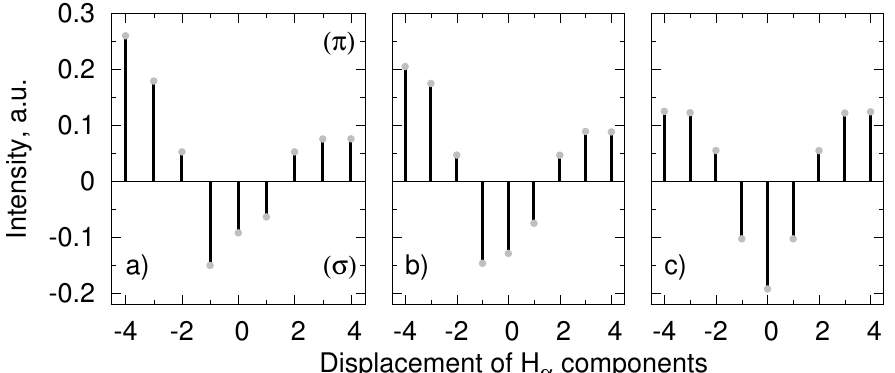
Figure 6. The Stark effect for the Balmer- α line excited by proton impact at a collision energy of 50 keV/u and by electrons with temperature of 3 keV. For the statistical intensities the ratio between components π ± : π ± : π ± : σ ± : σ 0 = 17.8:24.4:7.7:20.5:58.2, and for the dynamical intensities the 3 2 4 1